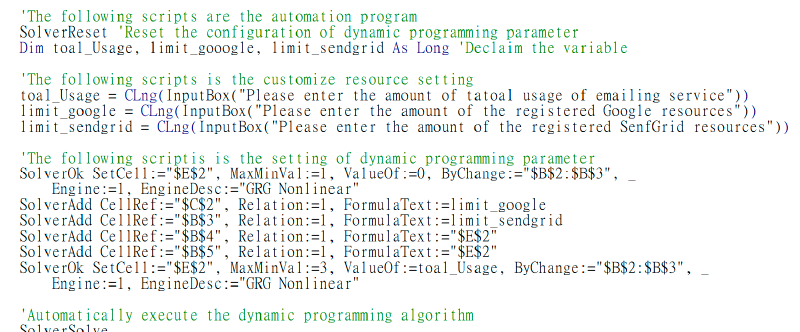
Figure 7. The automatic script runs the GRG non-linear solving method.